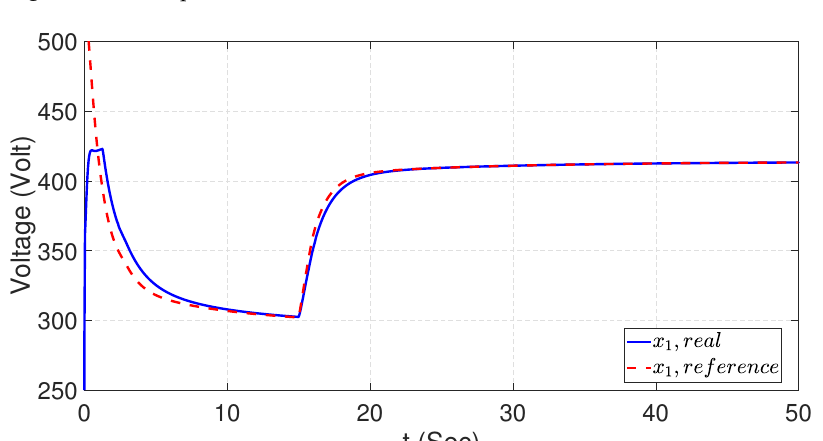
Figure 6. Motor speed control.